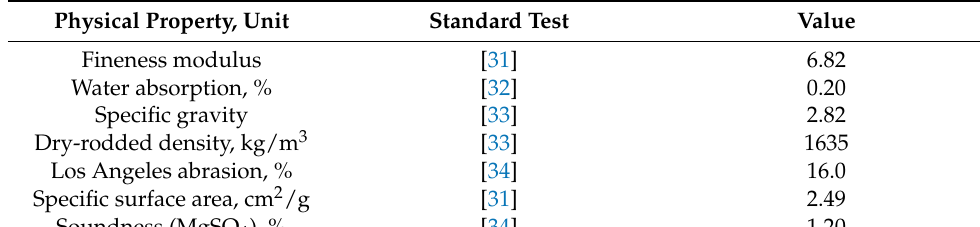
Table 2. Physical properties of natural aggregates (NA).